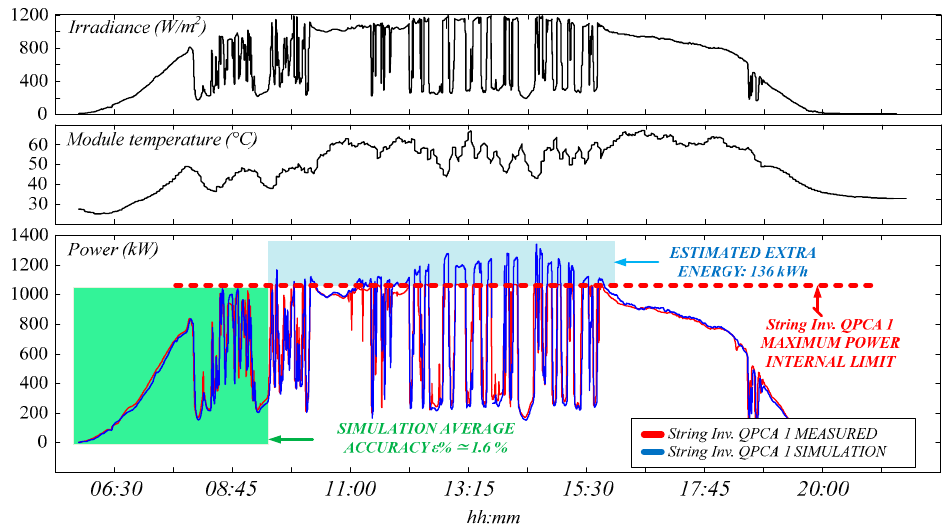
Figure 13. Model output vs. measured data of string inverters subsection QPCA 1 during a specific day. The integrated state-space average model is able to estimate the theoretical extra energy that the subfield could produce in absence of inverter internal maximum power threshold.